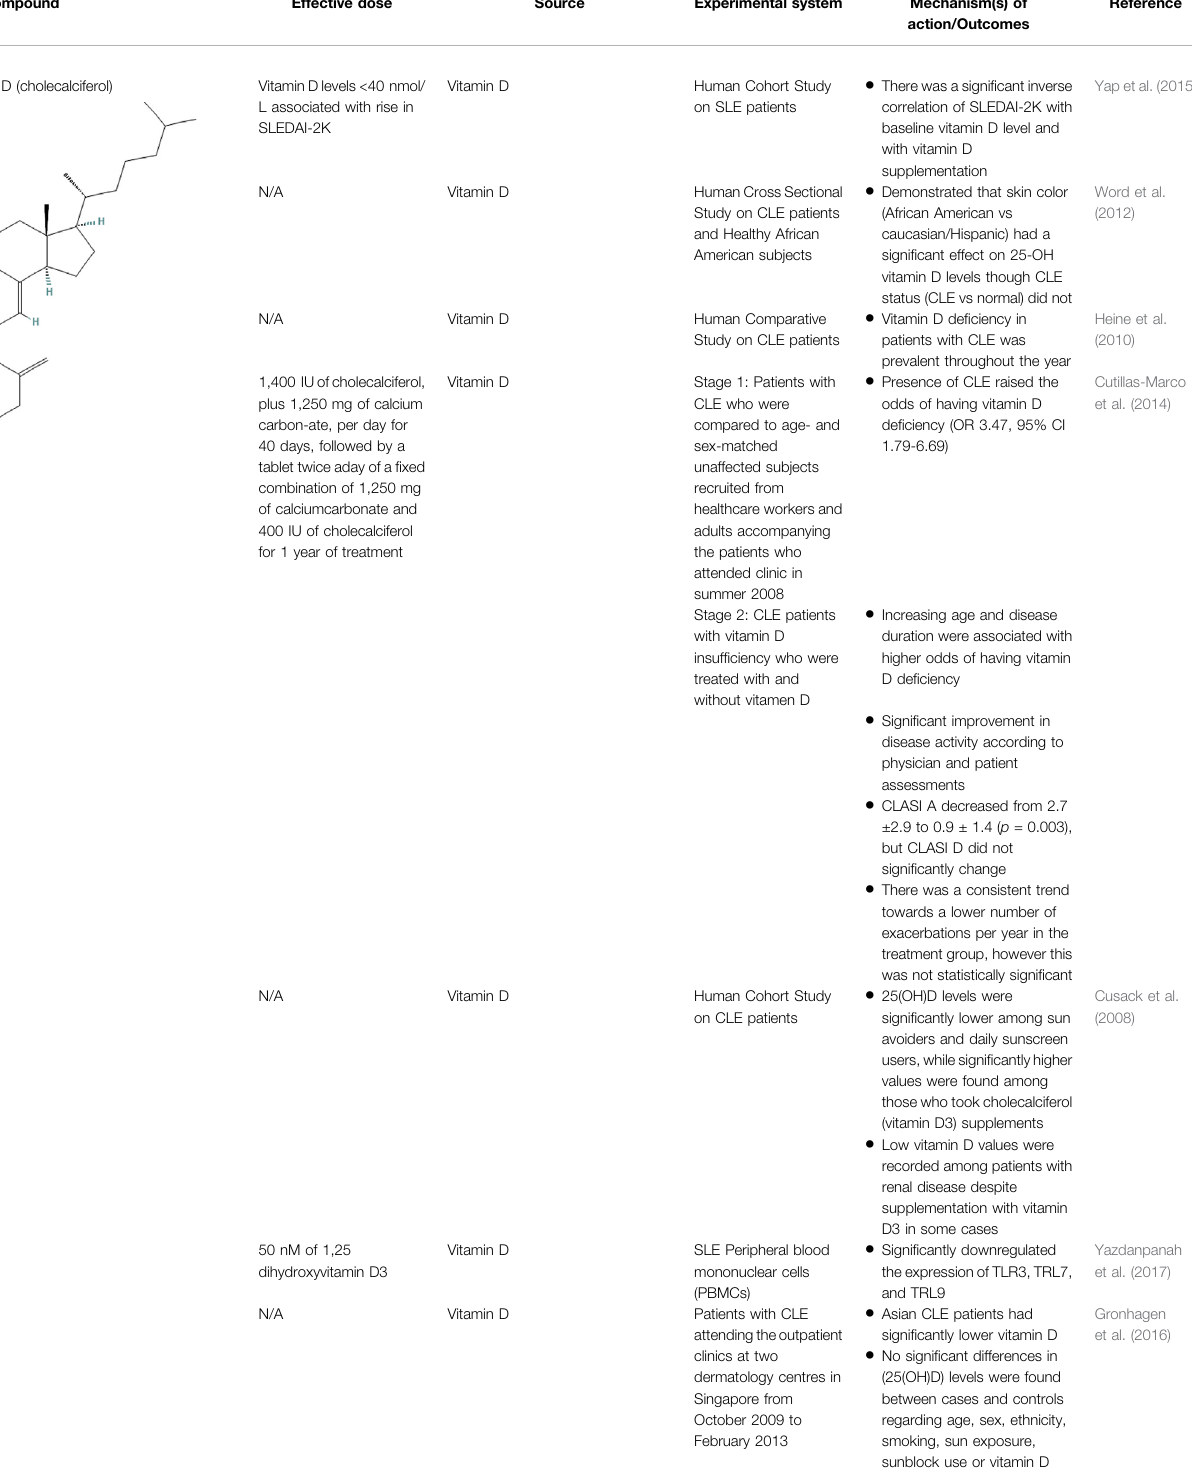
TABLE 1 | Synthesized fi ndings for potential bioactive compounds for